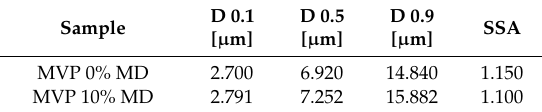
Figure 2. Micrographs of the MVPs particles using SEM with 500× magnification ( A1 , B1 ) and 1000× magnification ( A2 , B2 ) where A1, A2 represent MVP 0% MD and B1, B2 represent MVP 10% MD. Table 3. Particle size distribution of MVPs obtained by laser diffraction .